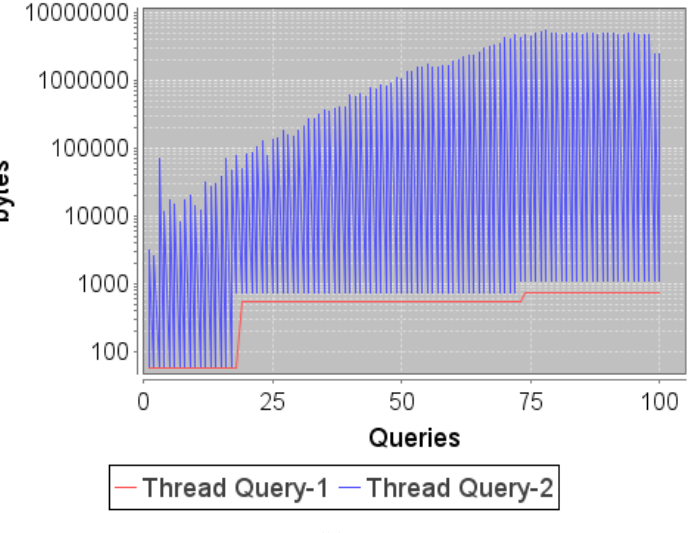
Figure 8. Simultaneous requests. Concurrent injections and data gathering. ( a ) Concurrent injection and data gathering. Injection and response time in ms (milliseconds). ( b ) Volume of data extracted by the consultant